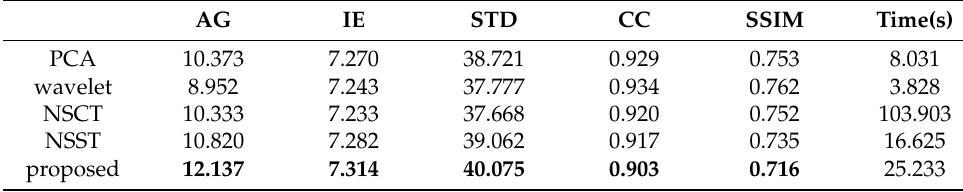
Table 1. Evaluation indexes of the fused images in scene 1.